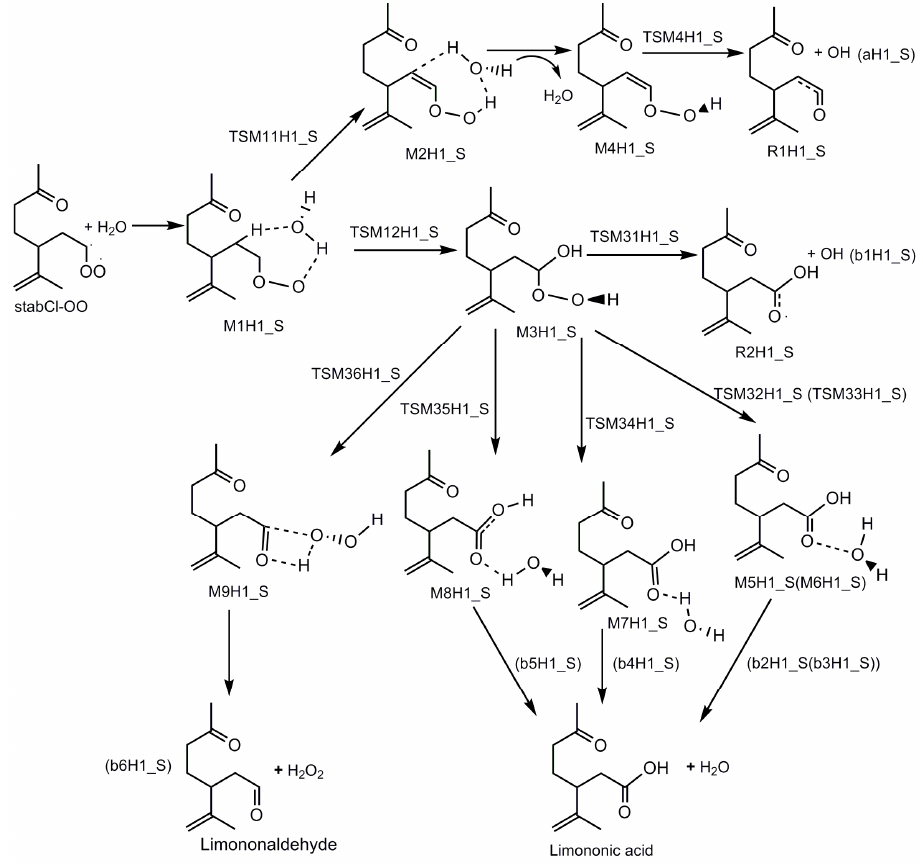
Scheme 2. Mechanistic diagram for the reaction between H the limonene